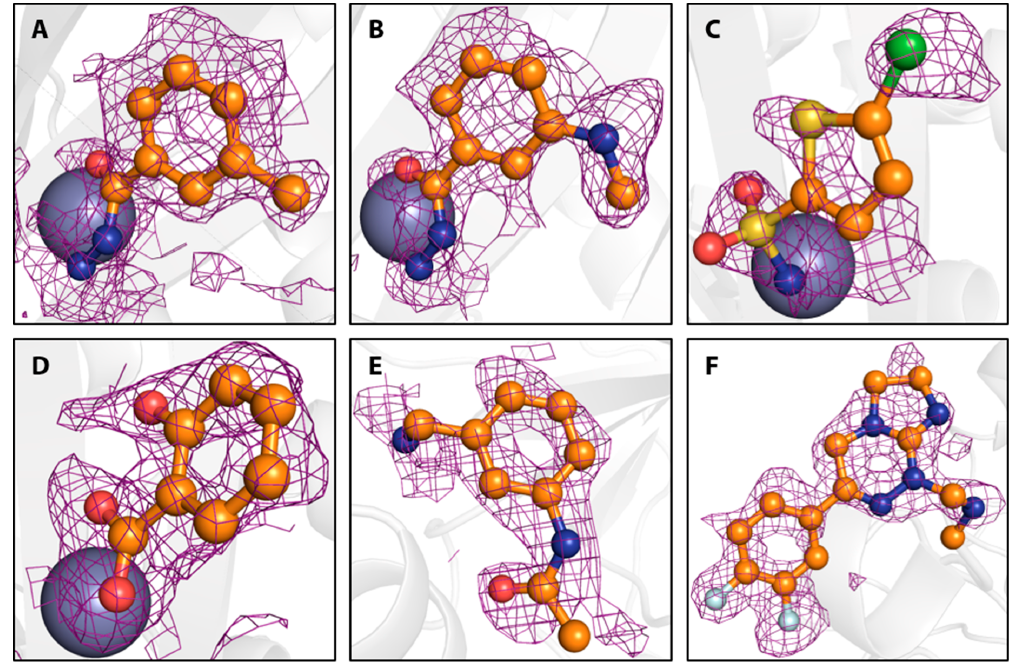
Figure 5. PanDDA density maps for identified fragment binding events shown at 2 σ . ( A ) 1 ( B ) 2 ( C ) 3 ( D ) 4 ( E ) 5 ( F ) 7 .